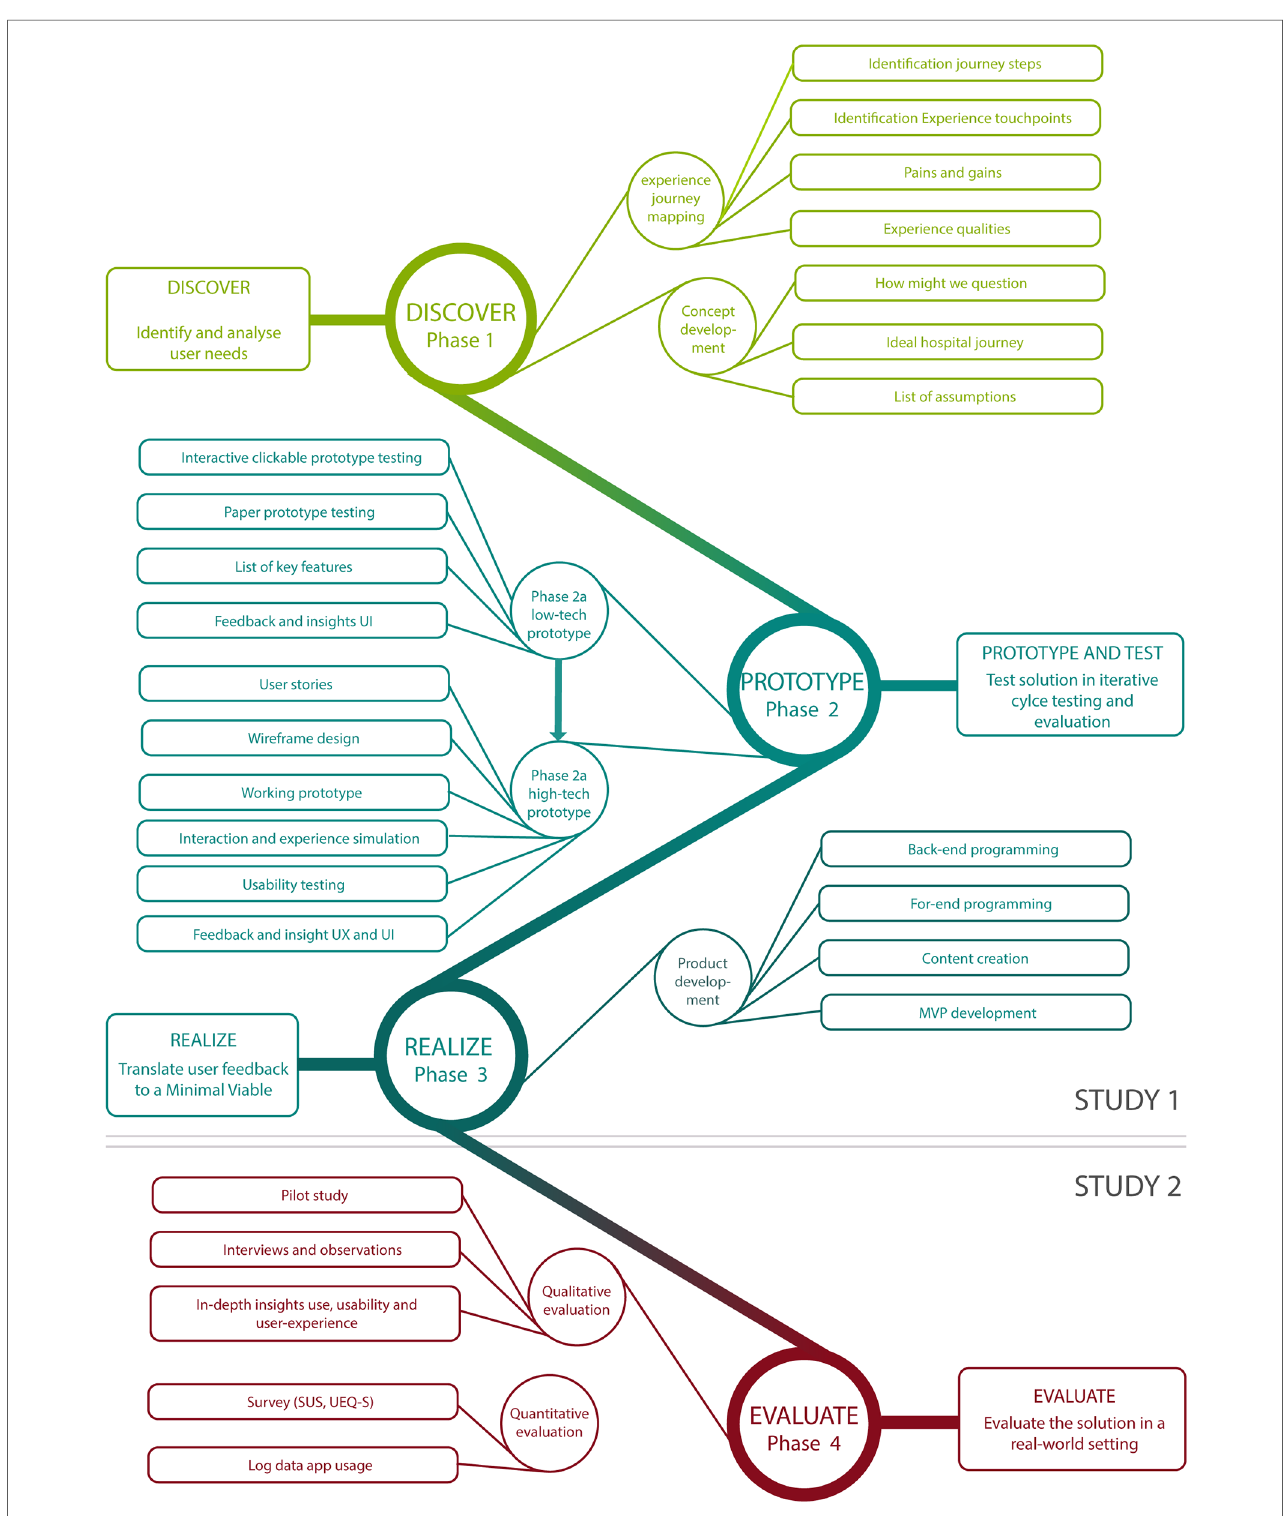
FIGURE 1 Schematic overview of study design of study 1 and study 2, mapped onto participatory design phases. UX, user experience; UI, user interactions; MVP, Minimum Viable Product; SUS, System Usability Scale; UEQ_S, User Experience Questionnaire Short